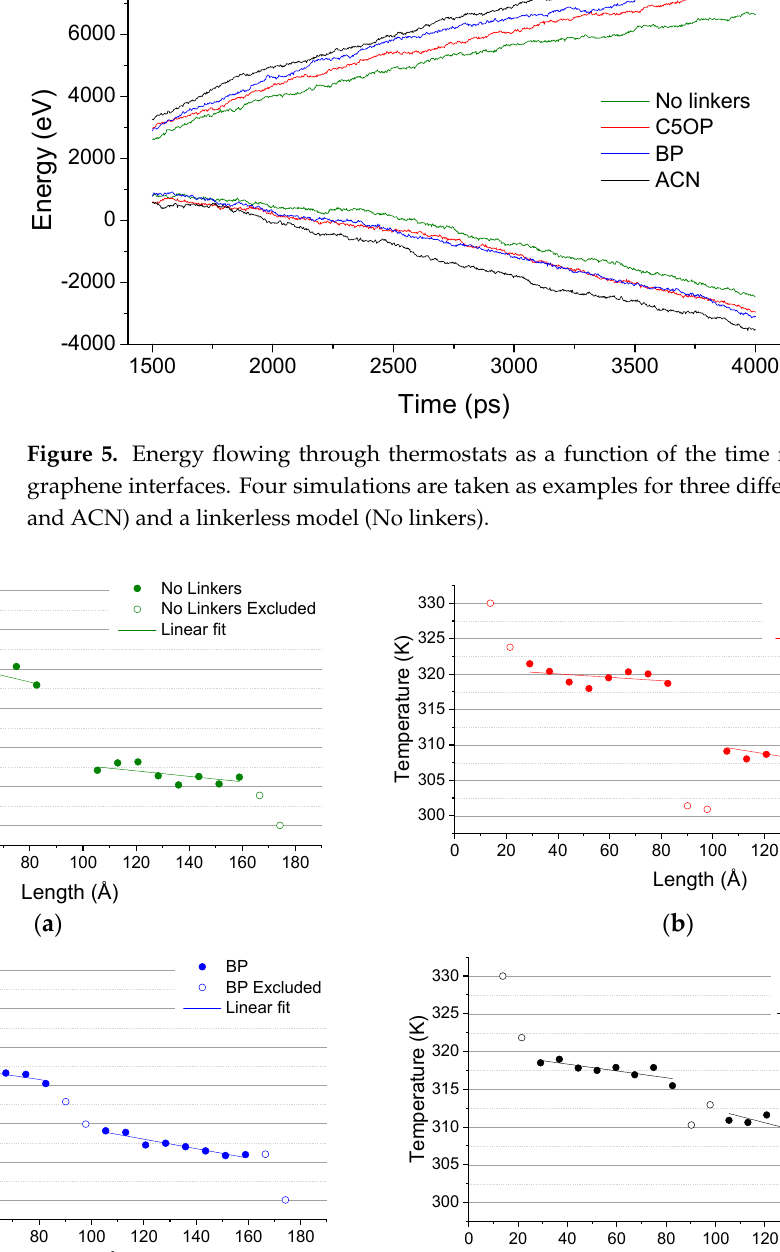
Figure 5. Energy flowing through thermostats as a function of the time for PDMS ‐ surrounded gra ‐ phene interfaces. Four simulations are taken as examples for three different linkers (C5OP, BP, and ACN) and a linkerless model (No linkers). Table 1. Averaged heat flux for different linkers in PDMS. Average value, thermostat variation, replica variation and linker gain as the ratio of linker heat flux over linkerless heat flux value.